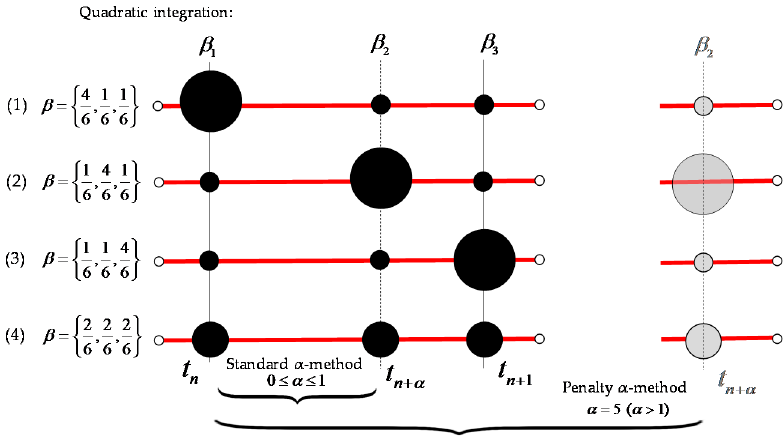
Figure 11. Quadratic single-step midpoint methods (SMPT1 and SMPT2): standard α -method and penalty α -method.